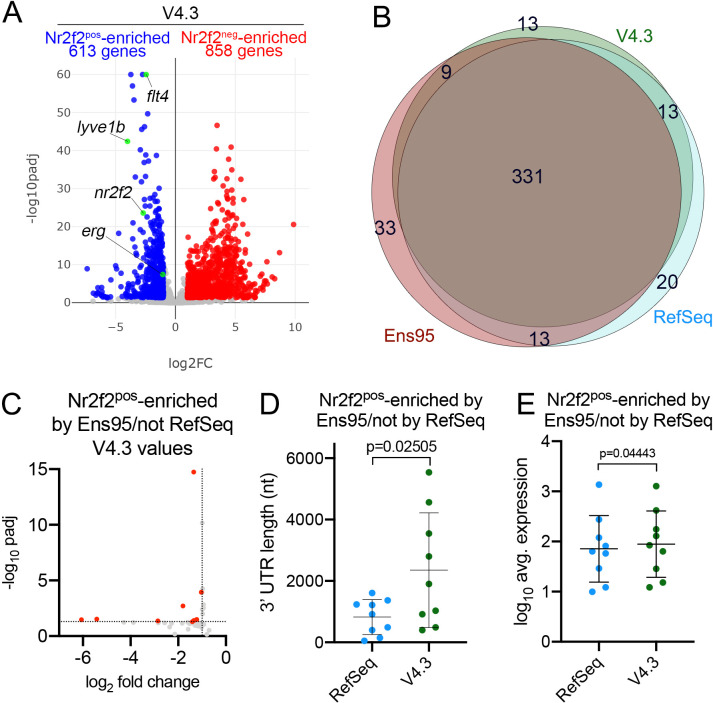
Analysis of Nr2f2pos and Nr2f2neg datasets using V4.3.(A) Volcano plot of RNA-seq data from Nr2f2pos and Nr2f2neg cells quantified using V4.3. Numbers of differentially expressed genes are shown. Selected known venous endothelial genes are indicated with green dots, as is erg, which is not detected as differentially expressed by Ens95. Genes with significant differences (padj <0.05) are red (log2 fold change pos/neg > 1) or blue (Nr2f2pos-enriched, log2 fold change pos/neg <-1). (B) Venn diagram showing intersection of reference genes (using commonly annotated NCBI ID) that are significantly enriched in Nr2f2pos-cells in each indicated annotation. (C) Volcano plot of Nr2f2pos-enriched reference genes identified only by Ens95 in comparison to RefSeq. Indicated values are from the same genes quantified using V4.3. Red dots indicate log2 fold change<-1 and adjp <0.05. (D) 3' UTR lengths and (E) log10 average expression (n = 3) for reference genes in Ens95 and V4.3 for the indicated dataset. (D, E) Data are normally distributed, paired t-test, p values are indicated. Error bars denote mean and standard deviation.